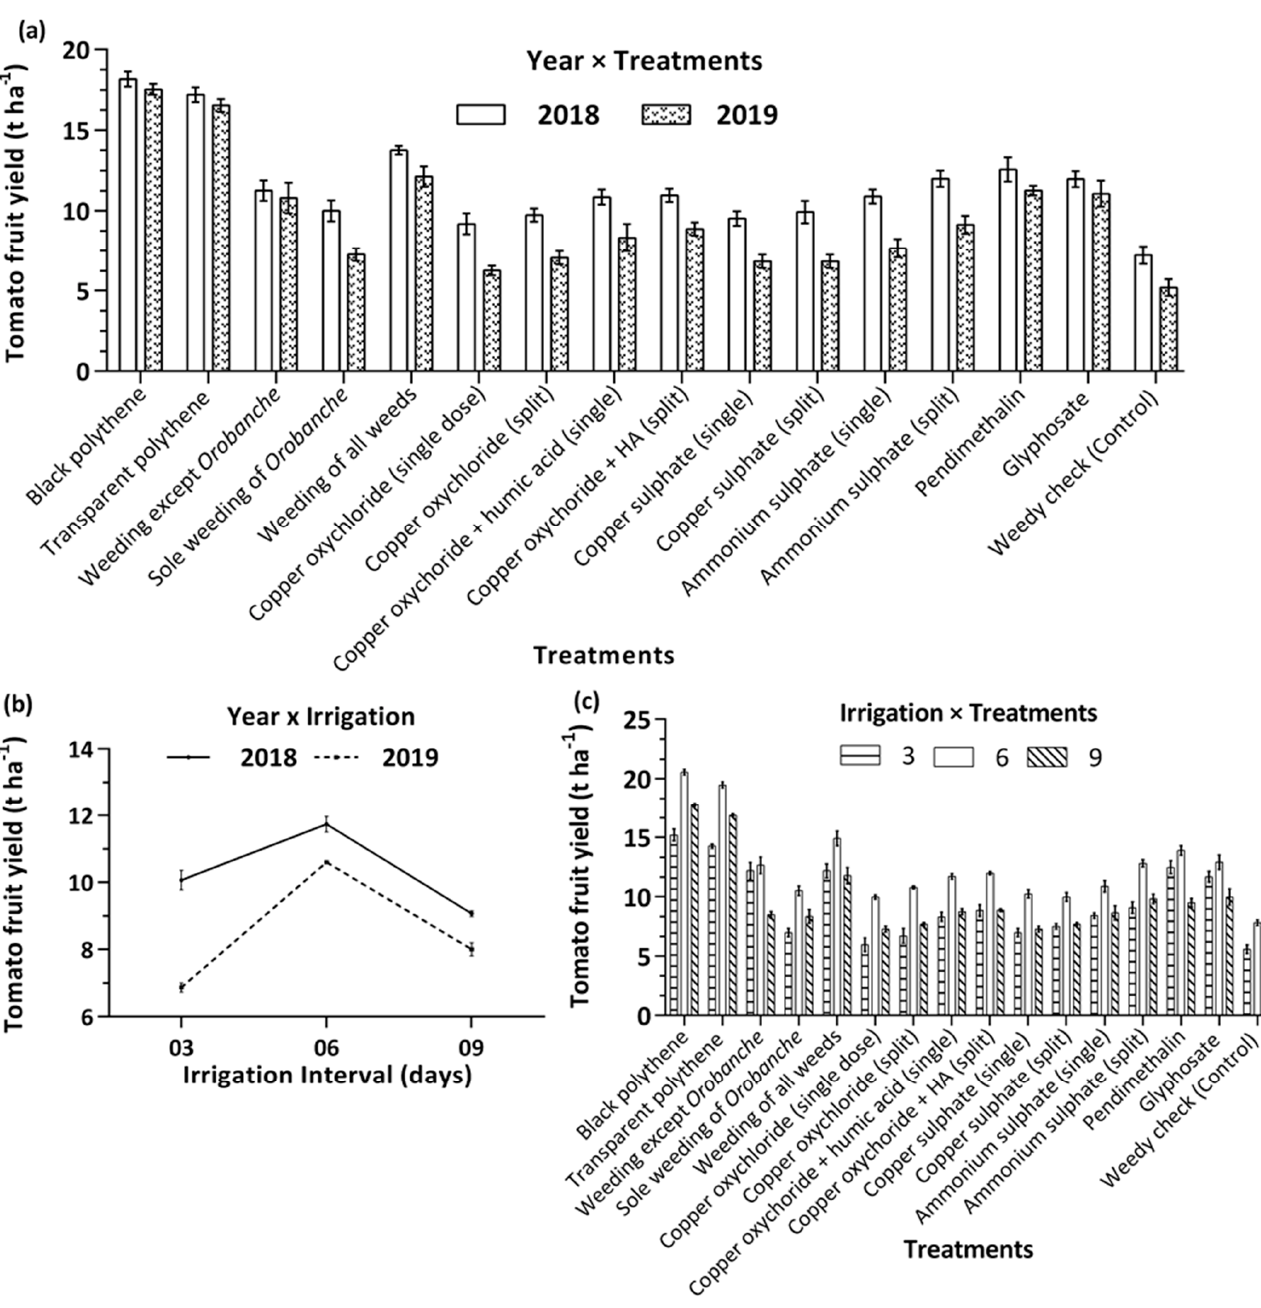
Figure 14. Influence of various interactions on tomato fruit yield tons ha − 1 of tomato. ( a ) Interaction effect of year × treatments on tomato fruit yield. ( b ) Interaction effect of year × irrigation tomato on fruit yield. ( c ) Interaction effect of irrigation × treatments on tomato fruit yield.